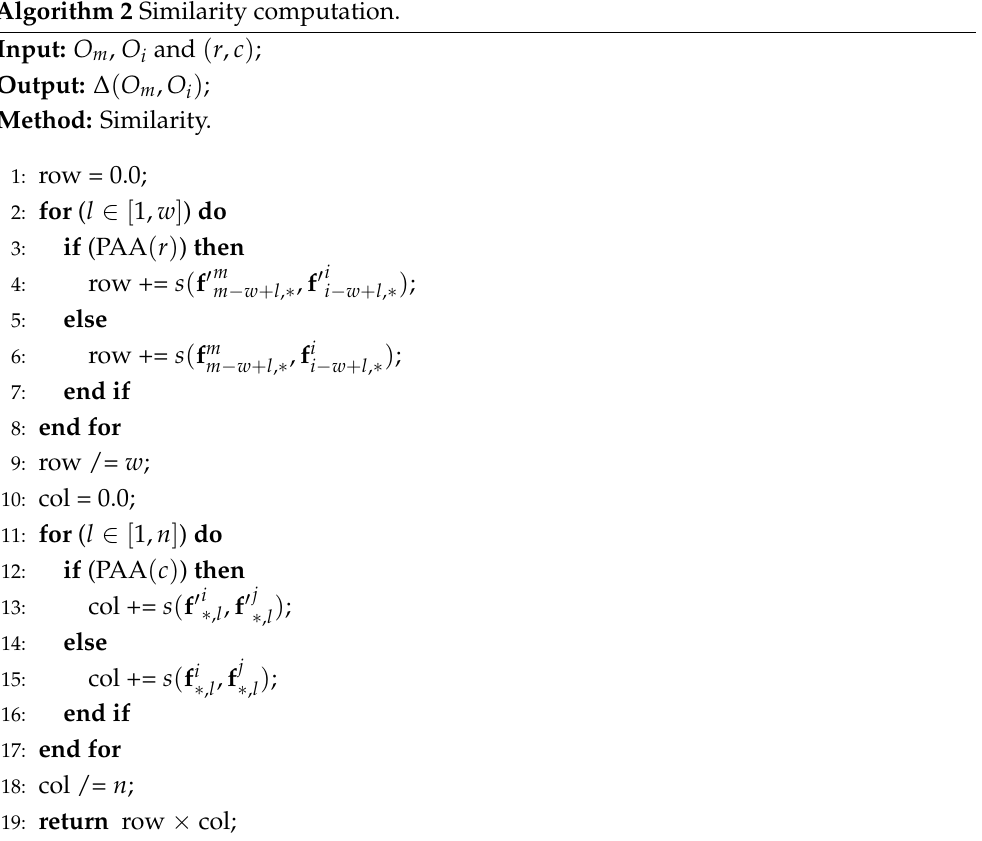
Algorithm 2 Similarity